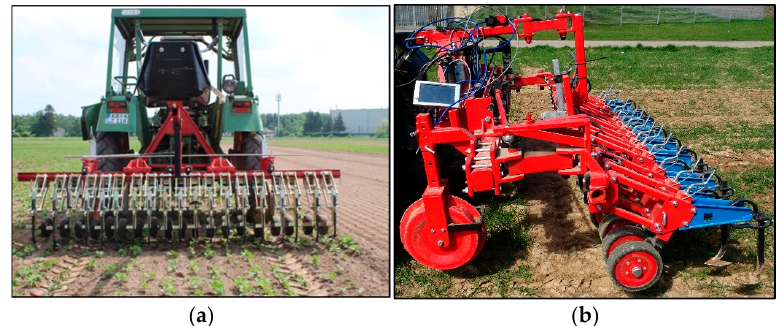
Figure 2. ( a ) Manual steered hoe (ARGUS, Kress Umweltschonende Landtechnik, Vaihingen an der Enz, Germany) with 100 mm wide no-till sweeps used in 2018; ( b ) camera guided hoe (iVision PV, Kress Umweltschonende Landtechnik, Vaihingen an der Enz, Germany) with camera steering control (Garford Farm Machinery Ltd., Peterborough, UK) and a RGB camera system (Tillett and Hague, Wrest Park, The Mansion, Bedford, UK) with 90 mm wide no-till sweeps used in all trials in the